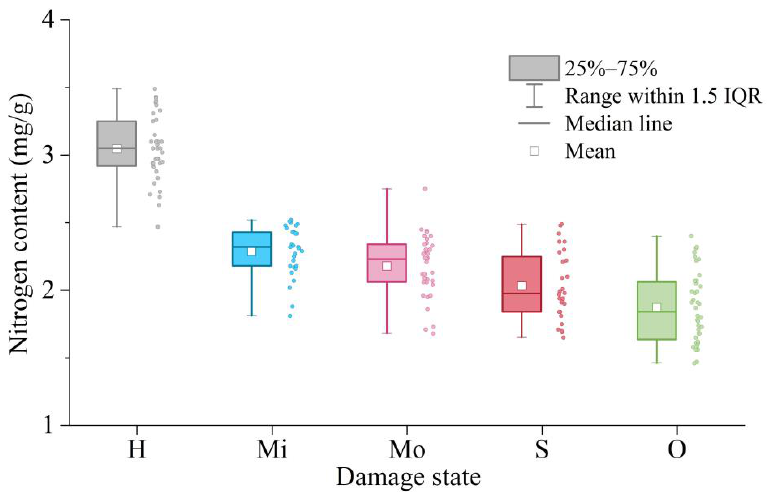
Figure 4. Trends in nitrogen content of Moso bamboo leaf samples in different damage states. The left side of each pair of graphs shows the box line plot for nitrogen content for that damage state, and the right side shows the actual distribution of data.